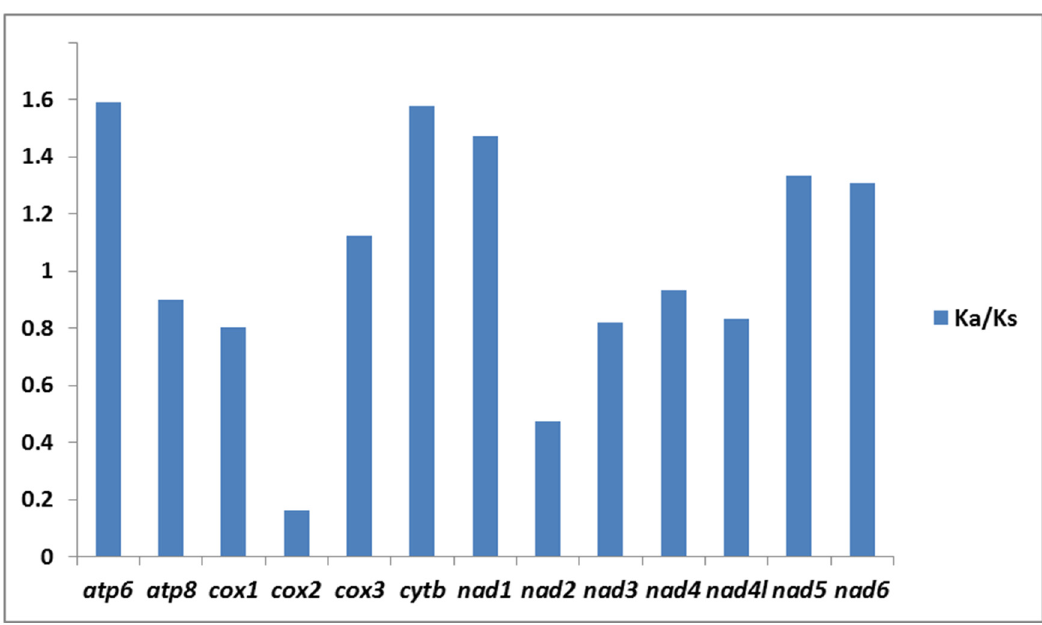
Fig 3. Evolutionary rates of PCGs in whitefly mitogenomes. The blue bar indicates the gene ’ s Ka/Ks.